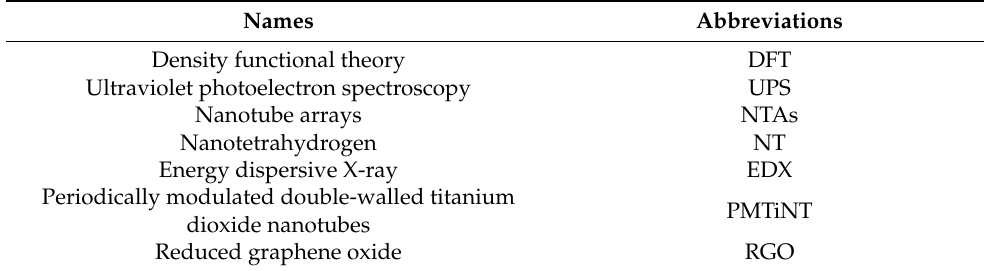
Table 3. Abbreviations of professional terms.